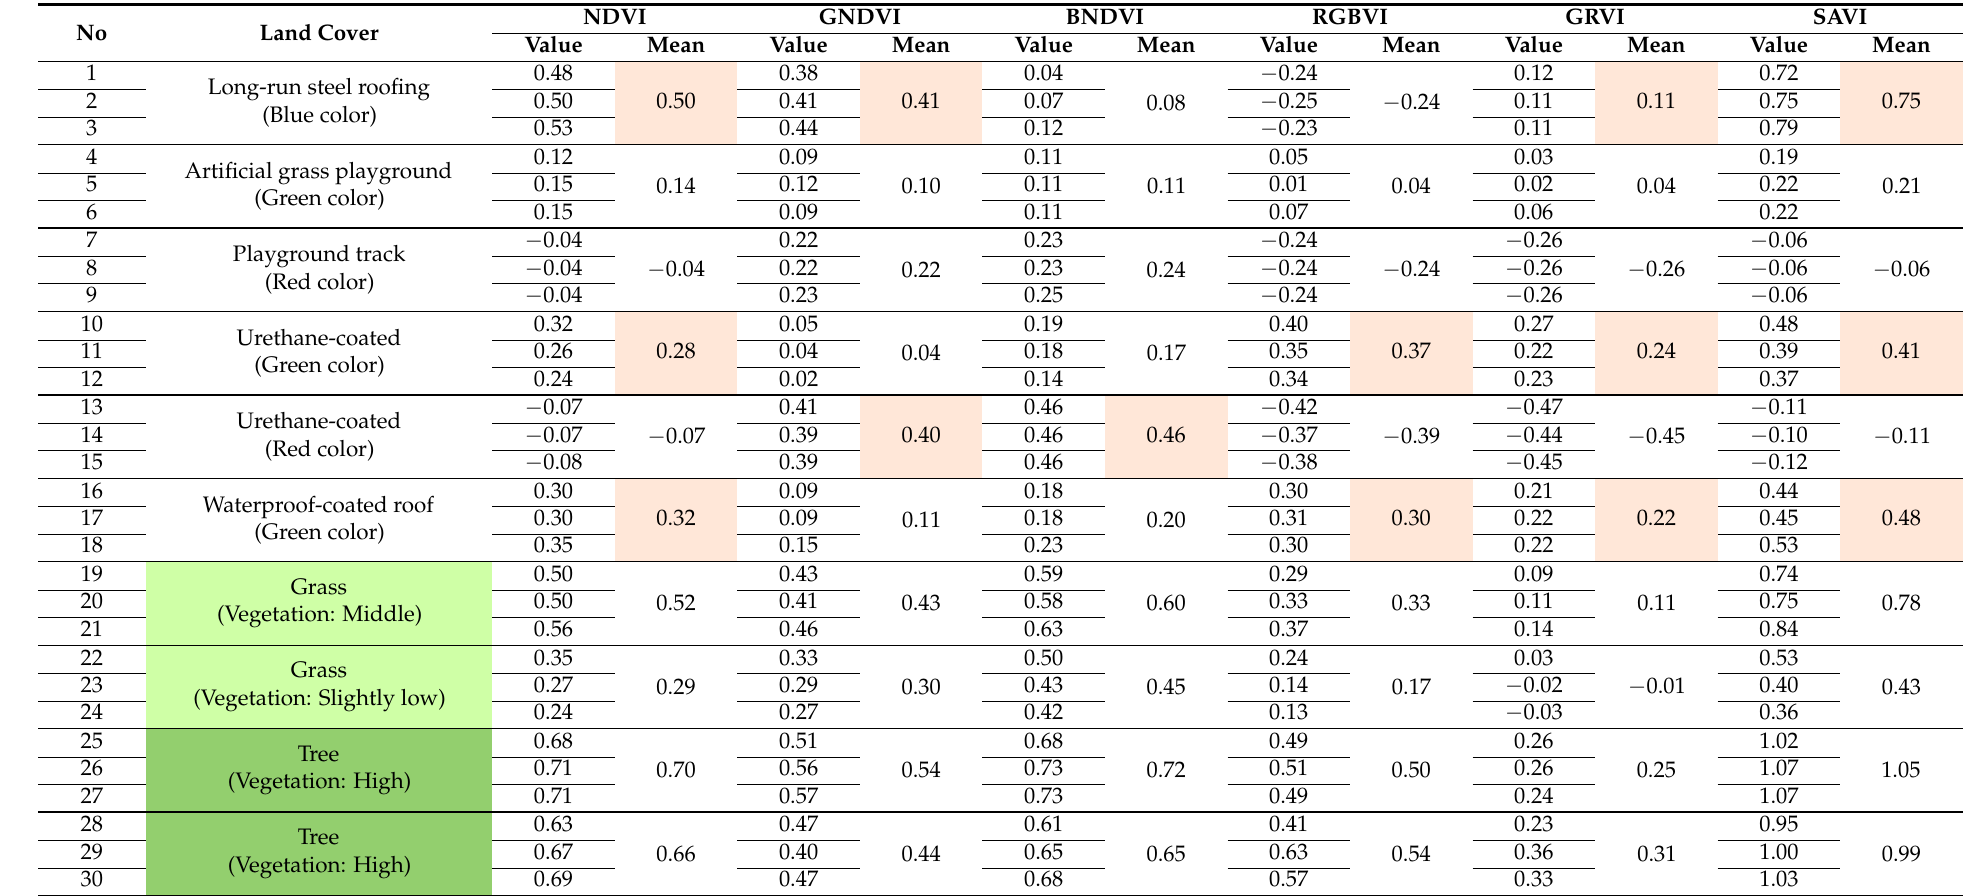
Table 5. Comparison of vegetation index values by type of land cover using the existing